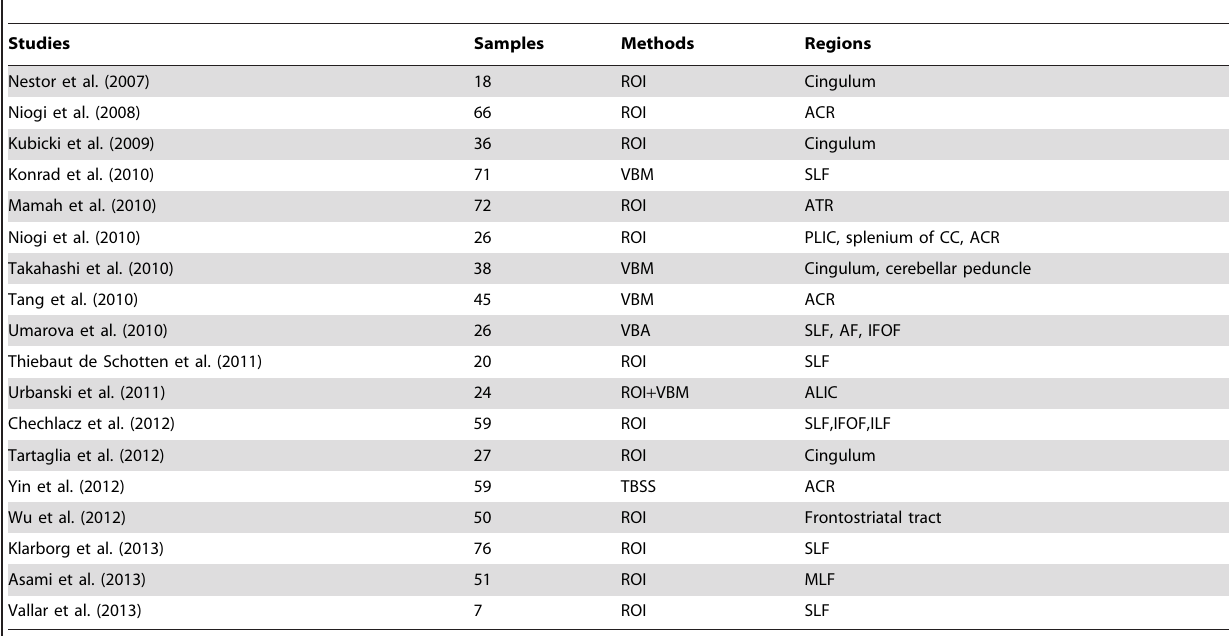
Table 1. A summary of the previous findings of white matter regions associated with attention.